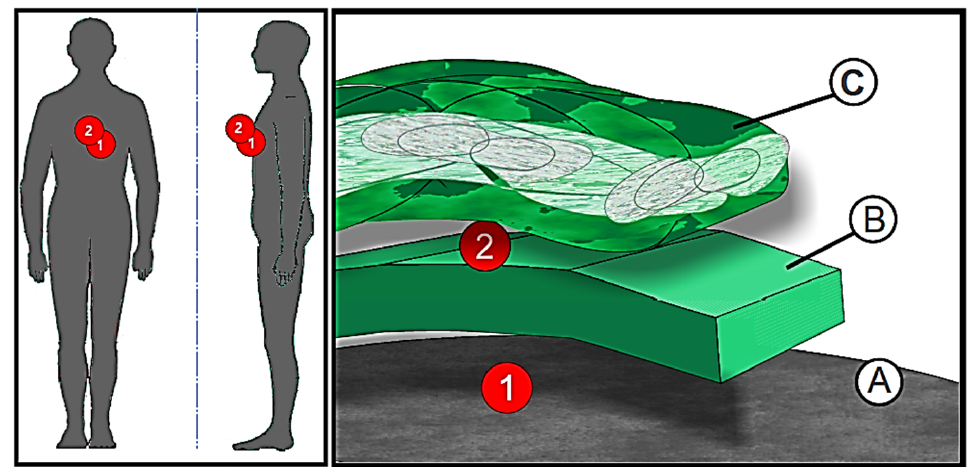
Figure 4. Graphical representation of the location of the temperature and humidity sensors: 1—Sensor between the body of the mannequin and the reference clothing; 2—Sensor over the reference clothing and under the sleeping bag; A—Body of the mannequin; B—Reference clothing; C—Sleeping